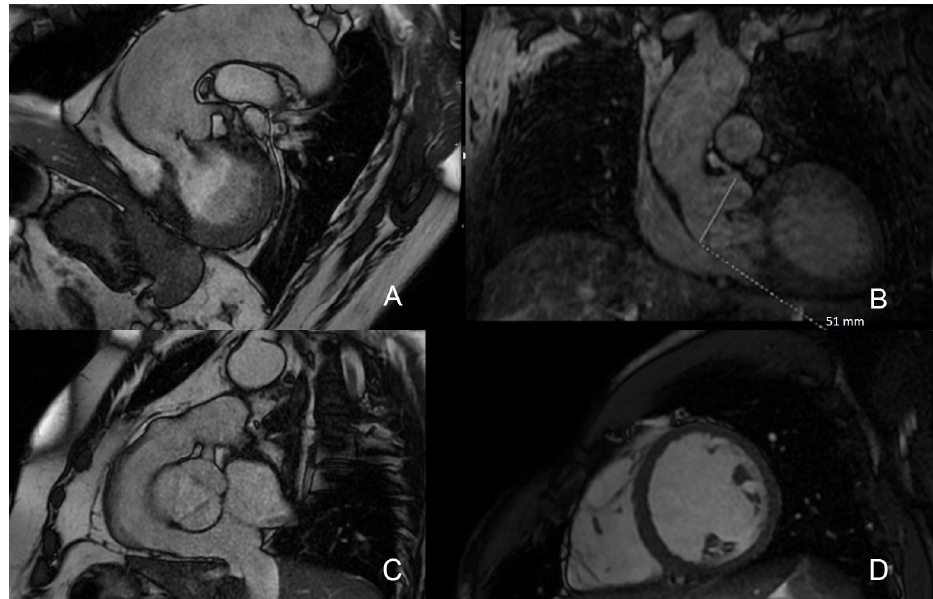
Figure 2. CMR SSFP sequences for AR assessment: ( A ) identification of regurgitant flow as signal void artifact; ( B ) assessment of aortic root; ( C ) aortic valve morphology evaluation; ( D ) left ventricle short-axis view. CMR: cardiovascular magnetic resonance; SSFP: steady-state free precession; AR: aortic